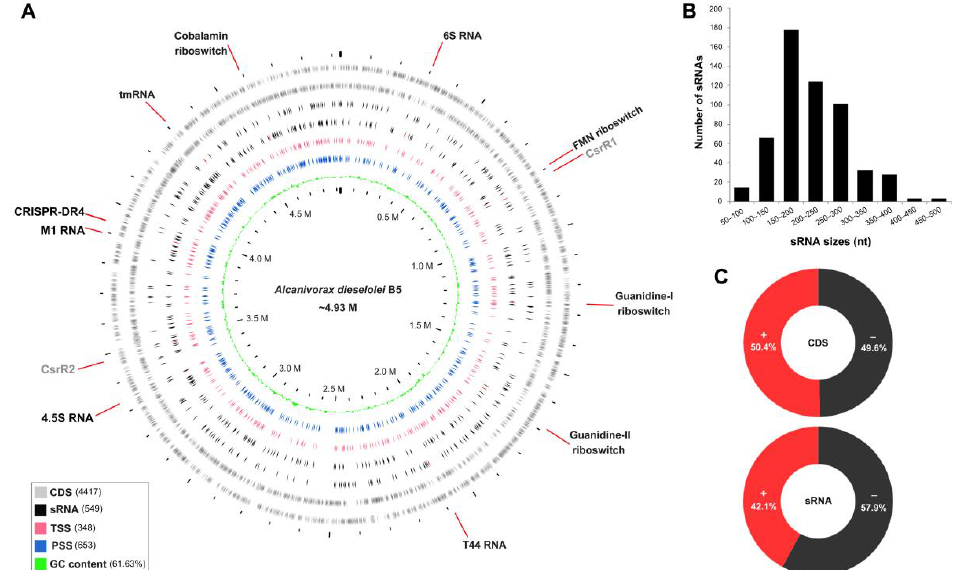
Figure 1. Genome-wide sRNAs landscape of A. dieselolei B-5. ( A ) Diagram shows the distributions of sRNAs, TSSs and PSSs across the B-5 whole genome. From outside to inside, the rings represent the distributions of CDSs, sRNAs, TSSs, PSSs and the GC content, respectively, and the values in brackets show corresponding numbers or percentages in the genome. The orientations of each ring are clockwise for the plus (+) strand and counterclockwise for the minus (-) strand. The relatively conserved sRNAs are red marked on the corresponding rings, and their annotated names are displayed on the outermost edges of the plot; black fonts for Rfam families and grey for identified CsrA-related sRNAs. Circos plot was created by using Proksee (https://proksee.ca/, accessed on 23 March 2022). ( B ) The size distribution of sRNAs. ( C ) Comparison of the distributing proportions of CDSs and sRNAs in two strands (+/-) of the genome.